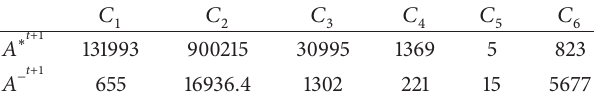
Table 11: PIS and NIS (year of 2005).